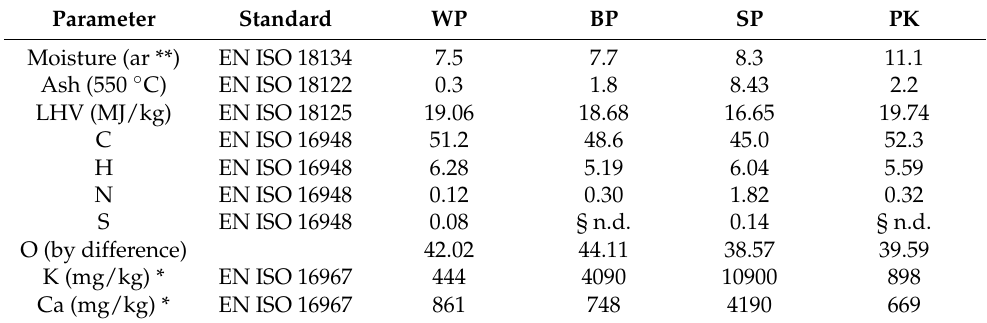
Table 1. Fuel specifications of the biomasses used in cooking experiments (* db,